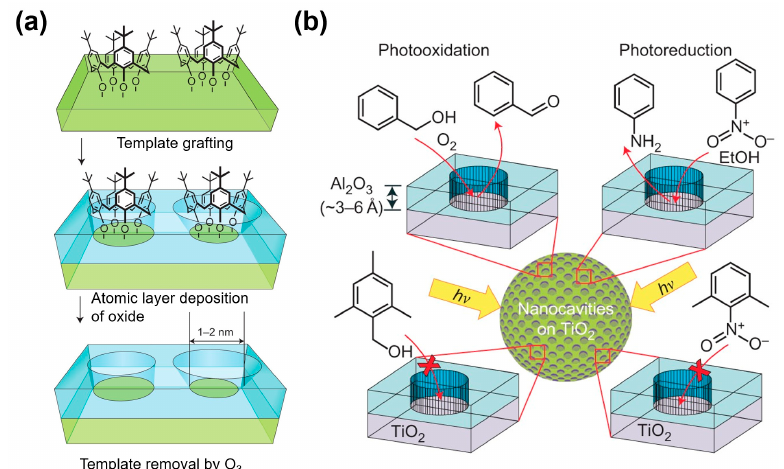
Figure 26. ( a ) The fabrication process of molecules imprinted oxide; and ( b ) the preferential reaction with gas species. Reprinted from reference [359] with permission from the Nature publishing group.